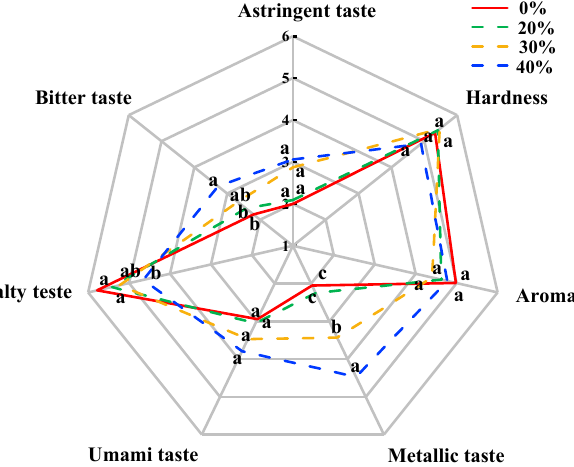
Figure 4. Sensory evaluation of traditional dry sausages with different KCl substitution ratios at day 12. a–c Means differ significantly among the different treatments ( p < 0.05). 0%: control dry sausage (2.50% NaCl); 20%: dry sausage with 20% KCl substituted for NaCl (2.00% NaCl + 0.50% KCl); 30%: dry sausage with 30% KCl substitution (1.75% NaCl + 0.75% KCl); 40%: dry sausage with 40% KCl substitution (1.50% NaCl + 1.00%